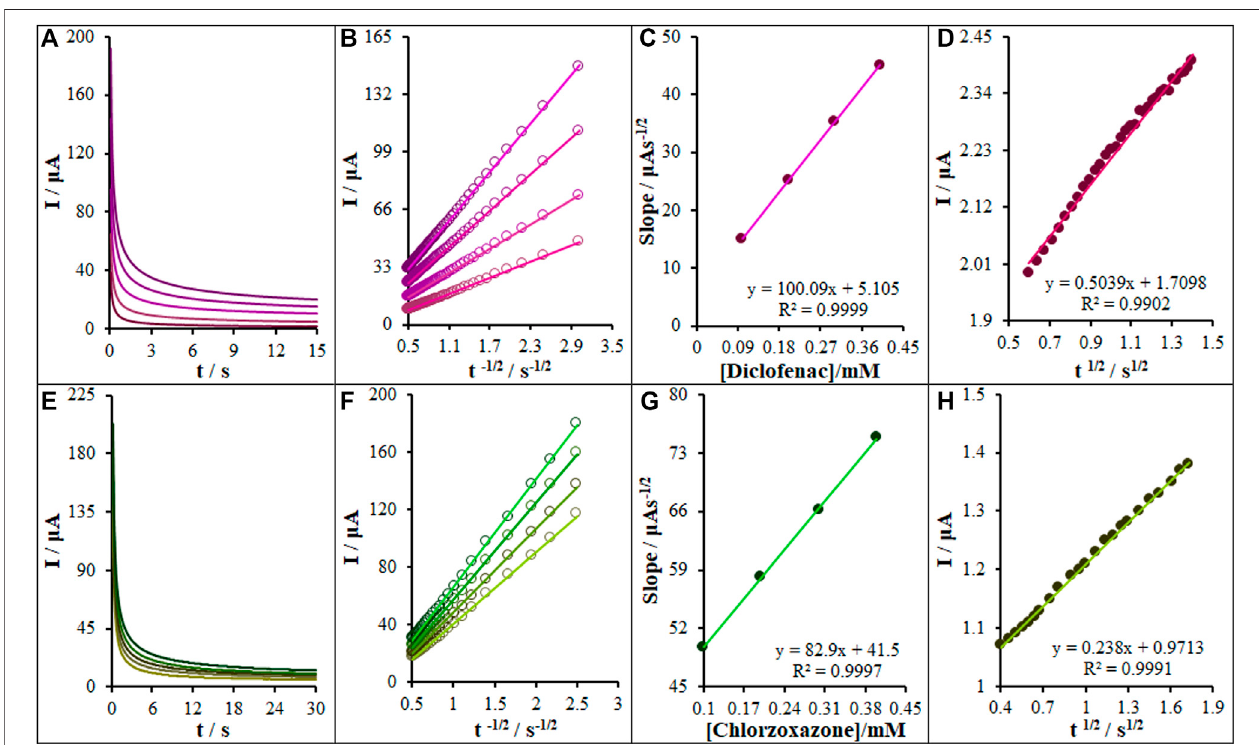
FIGURE 10 | (A) Chronoamperograms obtained at La 2 O 3 @SF-L Cu 2 S/GCE in 0.1 M PBS (pH 7.0) for different concentrations of diclofenac (from inner to outer curve): 0.0, 0.1, 0.2, 0.3, and 0.4 mM. (B) Plots of I vs t − 1/2 obtained from chronoamperograms 2 – 5. (C) The plot of the slope of the straight lines against diclofenac concentration. (D) TheplotofIC/ILvs. t 1/2 obtainedfromchronoamperogramsoneand two. (E) ChronoamperogramsobtainedattheLa 2 O 3 @SF-LCu 2 S/GCEin0.1 M PBS (pH 7.0) for different concentrations of chlorzoxazone (from inner to outer curve): 0.0, 0.1, 0.2, 0.3, and 0.4 mM. (F) Plots of I vs t − 1/2 obtained from chronoamperograms 2 – 5. (G) The plot of the slope of the straight lines against chlorzoxazone concentration. (H) The plot of IC/IL vs. t 1/2 obtained from chronoamperograms one and two.